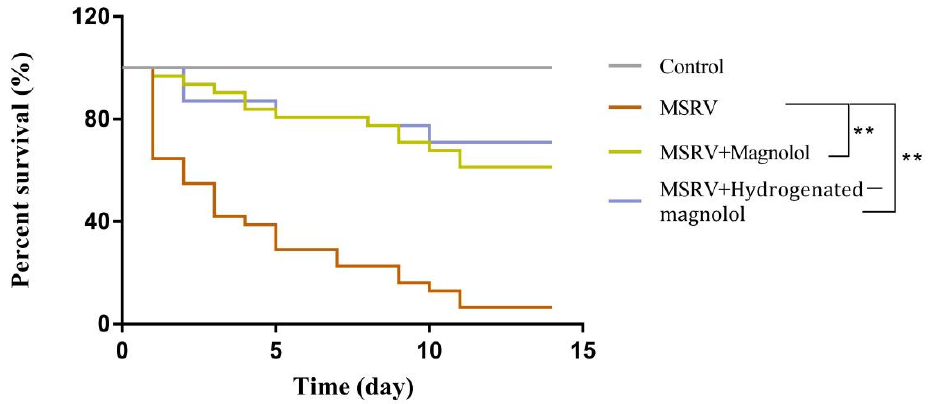
Figure 8. Survival curves of fish intraperitoneally injected with MSRV (1 × 10 6 TCID 50 ) and magnolol/hydrogenated magnolol at a concentration of 20 mg/kg. ** p < 0.01.